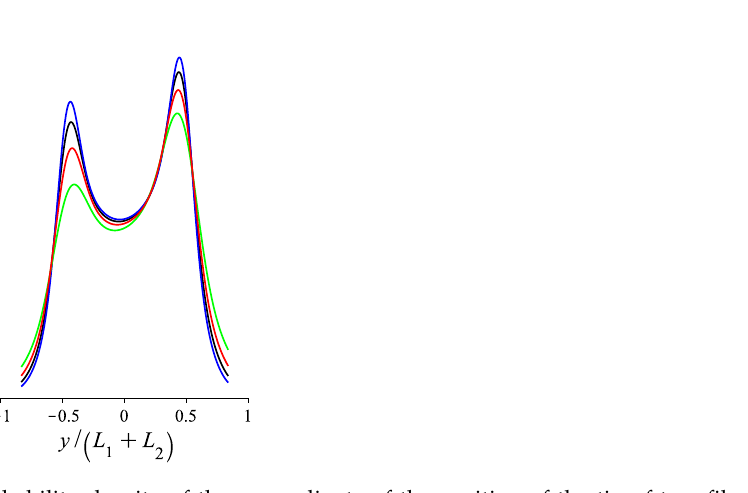
; θ µ = 0m; K B = 0.5; γ 0 = 0; 2